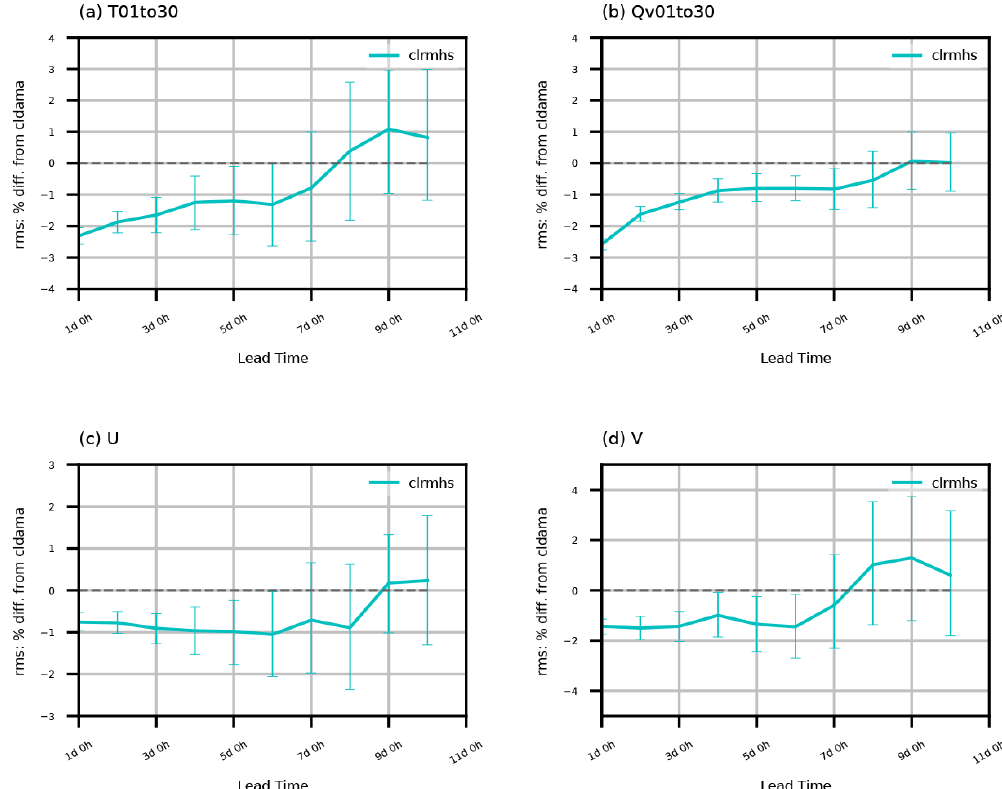
Figure 10. Similar to Fig. 8 but for clrmhs versus clrdma of four upper-air variables.